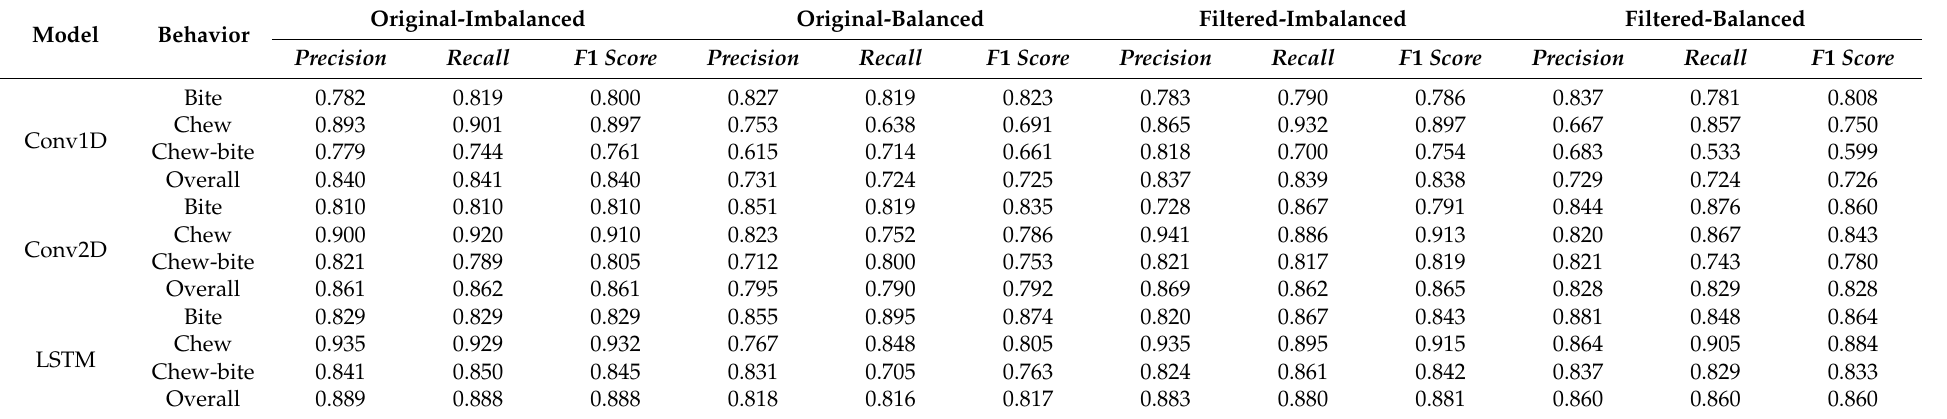
Table 3. Precision , recall , and F 1 score of the three deep learning models for classifying the ingestive behaviors in various